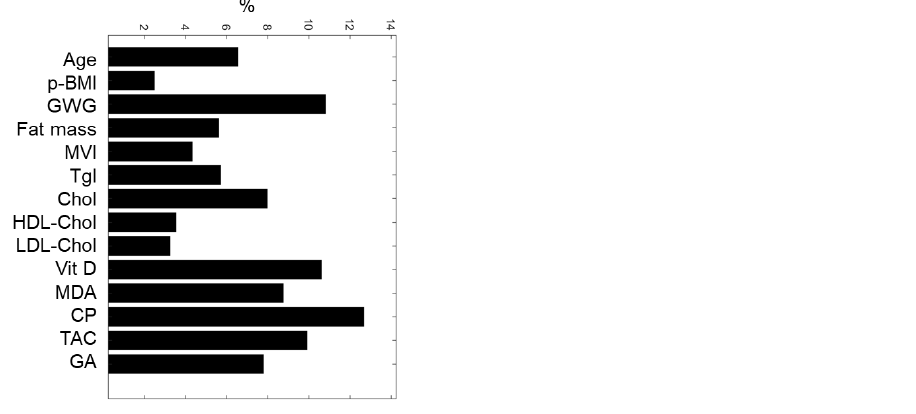
Figure 2. ANN maternal feature classification. Five maternal input variables with the highest rela- tive importance for predicting SGA or AGA newborns were: CP, GWG, Vit D, TAC, and MDA. pBMI, pre-gestational BMI; GWG, gestational weight gain; MVI, multivitamins; Tgl, triglycerides; Chol, total cholesterol; HDL-Chol, HDL cholesterol; LDL-Chol, LDL cholesterol; Vitamin D, Vit D; MDA, malondialdehyde; CP, carbonylated proteins; TAC, total antioxidant capacity; GA, gesta- tional age at